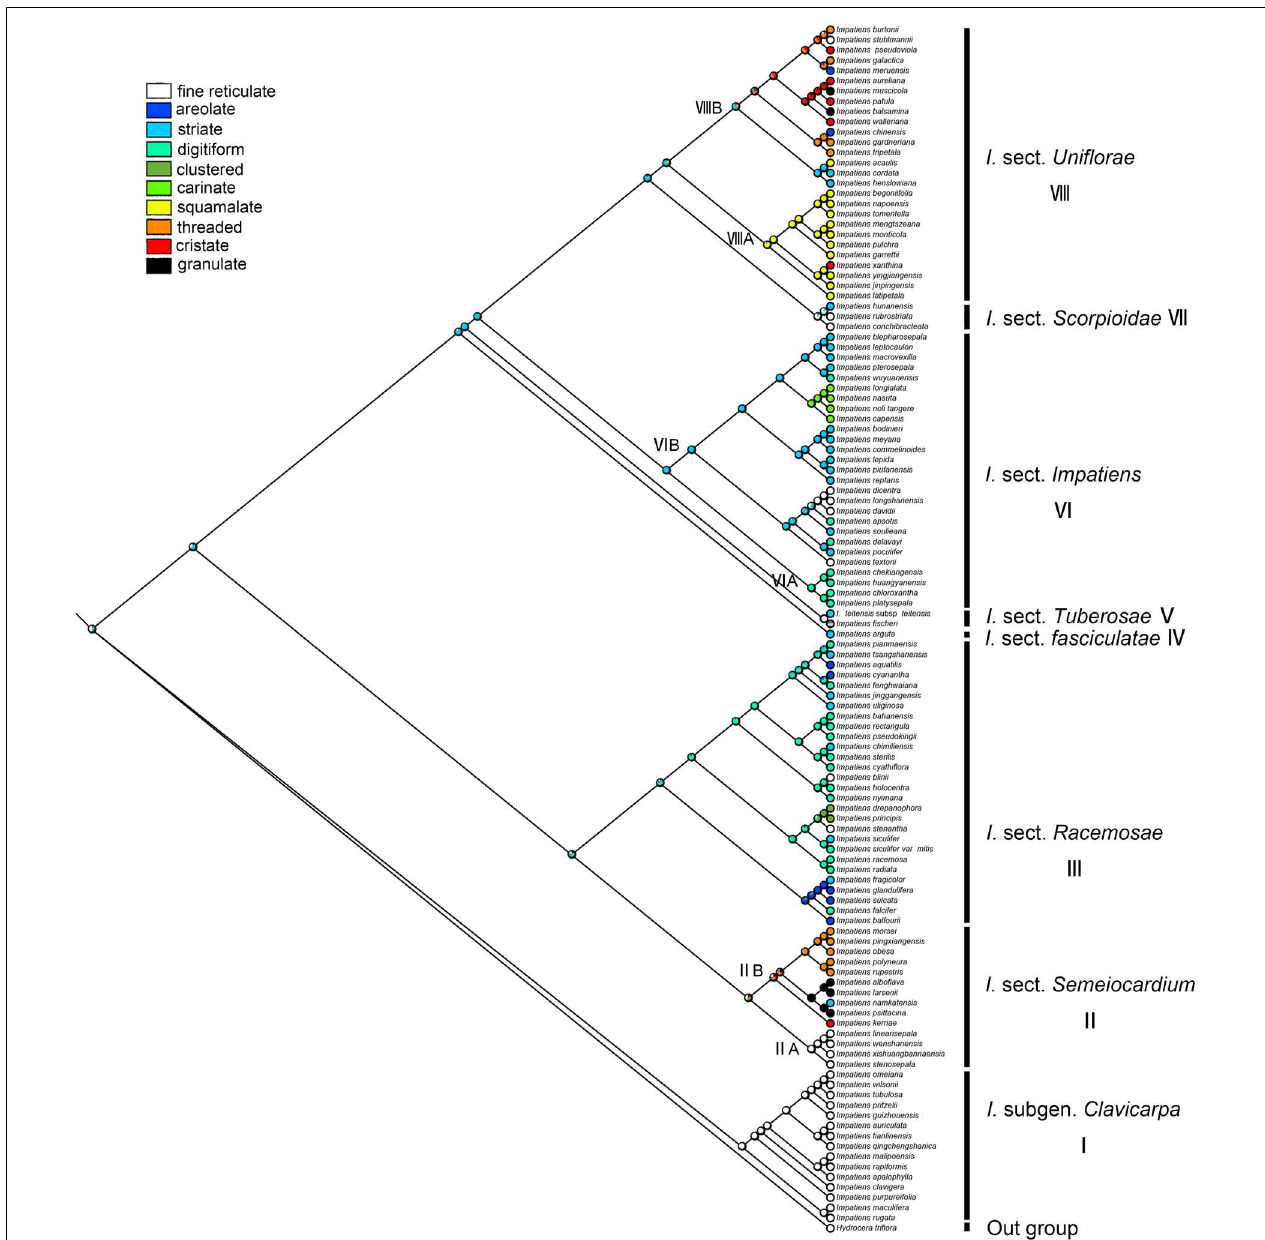
FIGURE 9 | Ancestral reconstruction of the secondary ornamentation in Impatiens using ML. Ten characteristic states of secondary ornamentation of Impatiens optimized on the BI tree by using different colors.